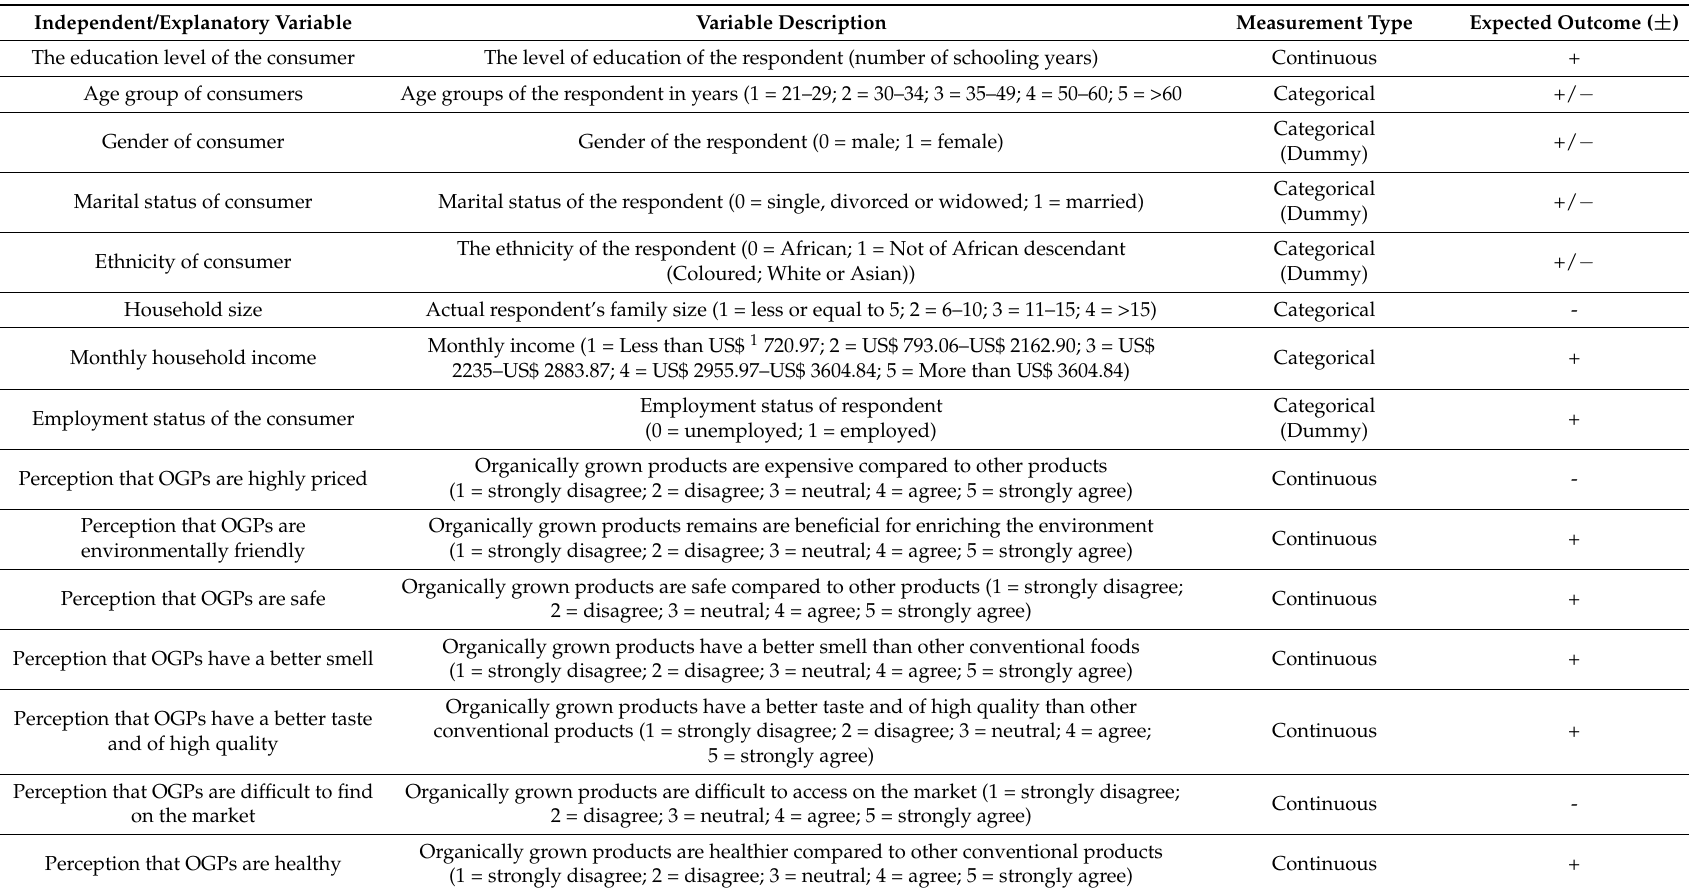
Table 1. Explanatory variables, description and their expected